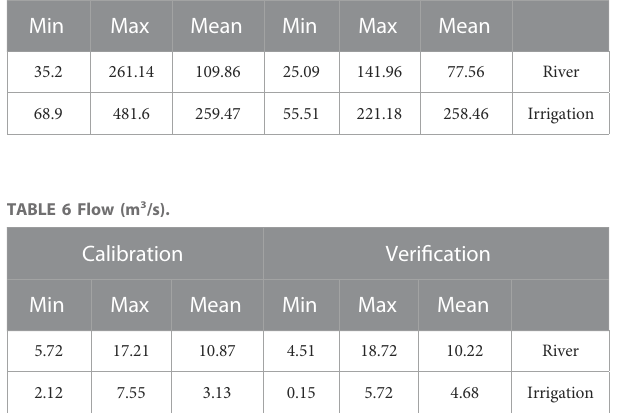
monitoring stations located along the catchment. In this way, the impact on MOHID Land simulations can be assessed. The parameters evaluated were velocity, fl ow and CS, the statistical indices (minimum, maximum and means) of the model are shown in a Tables 4 – 6. In order to evaluate the fi t of the model MOHID Water, although a global model (FES 2014) calibrated for the tide calculation is used, the Water Level output data of the model is comparing with the tide table of Bahía San Blas